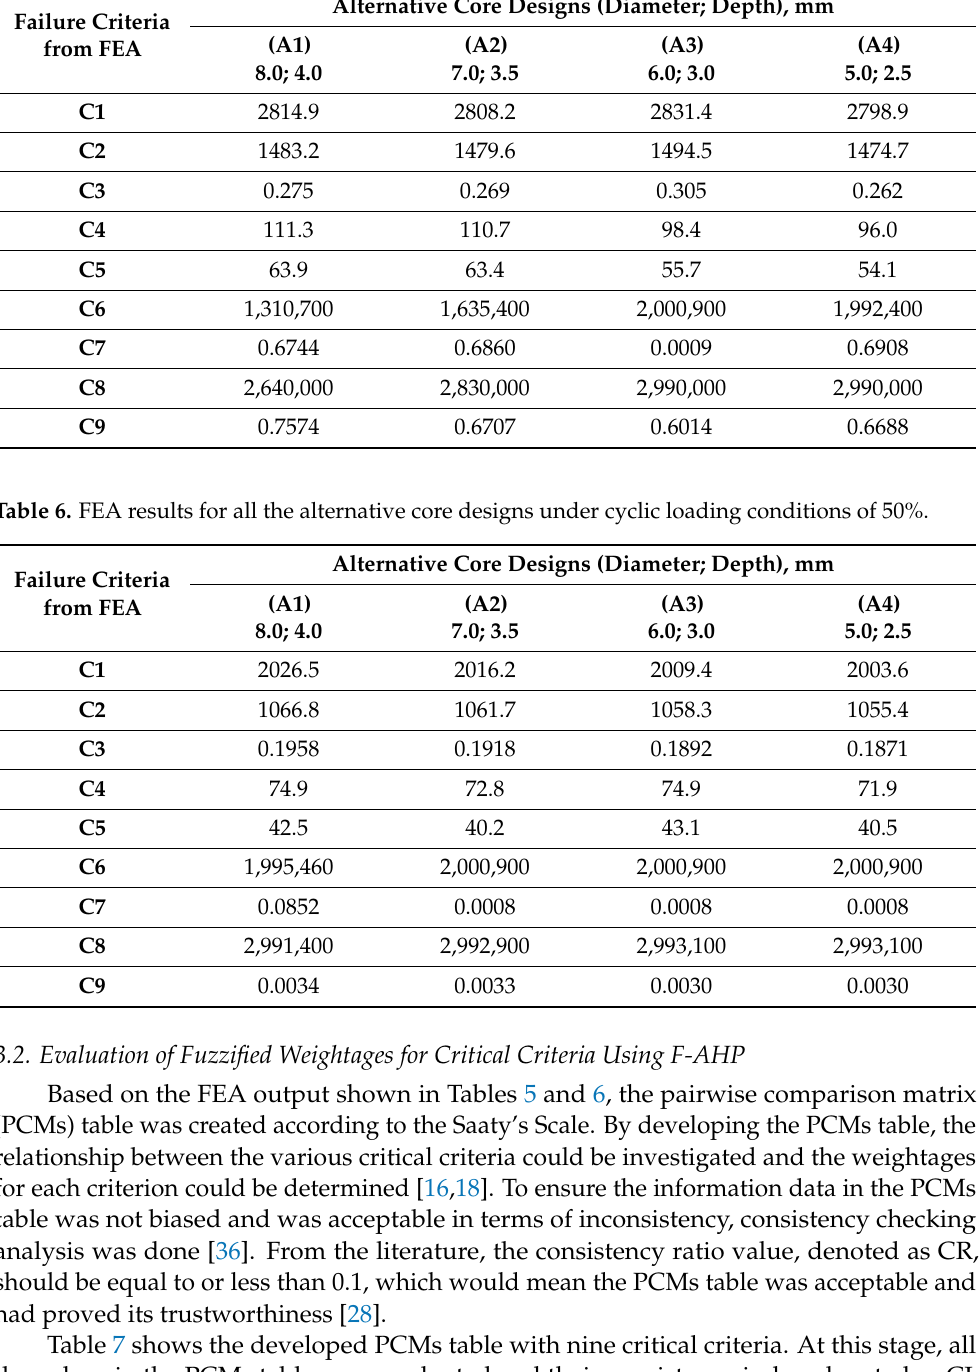
Table 5. FEA results for all the alternative core designs at 70% of cyclic loading conditions.